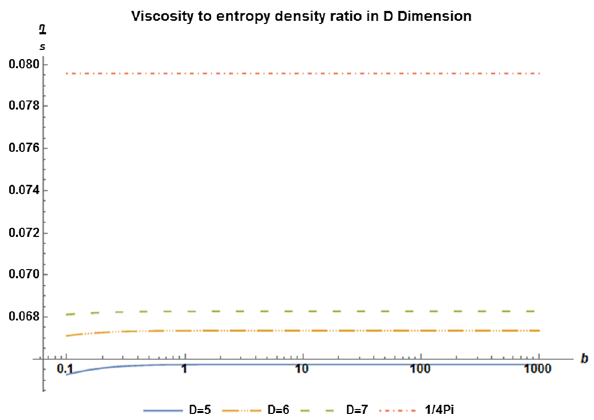
Fig. 5 Figure representing viscosity to entropy density ratio for differ- ent